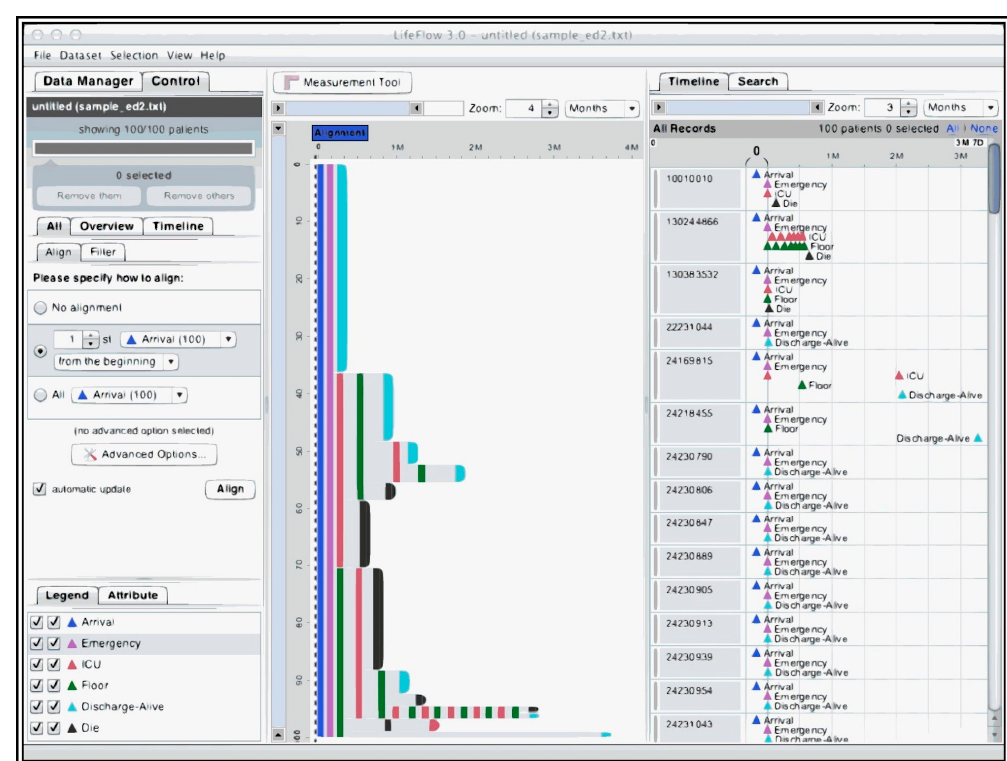
Figure 5. Lifeflow: Interactive visualization tool that provides an overview of event sequences. Source: Image courtesy of the University of Maryland Human–Computer Interaction Lab, http://hcil.umd.edu.